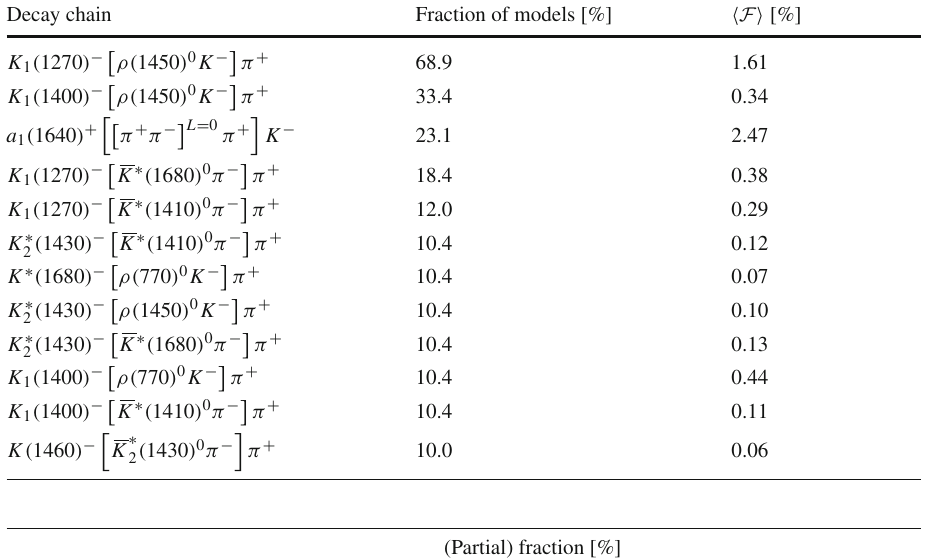
fractions (and partial fractions) on the choice of the RS model. This dependence is expressed as the mean value and the RMS of the values in the ensemble. Also shown is the fit fractions of the baseline model presented in Sect.